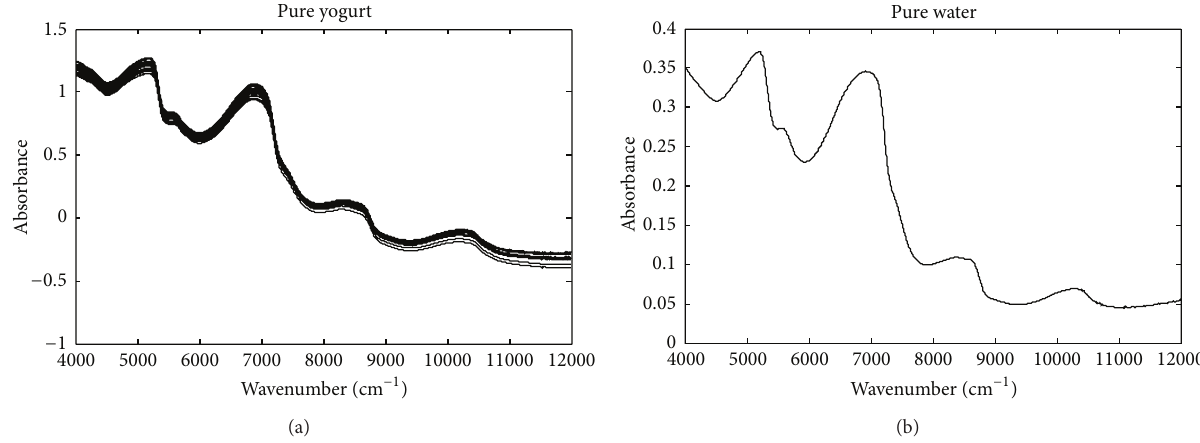
Figure 1: Typical raw NIR spectra of pure yogurt objects and the spectrum of pure water.